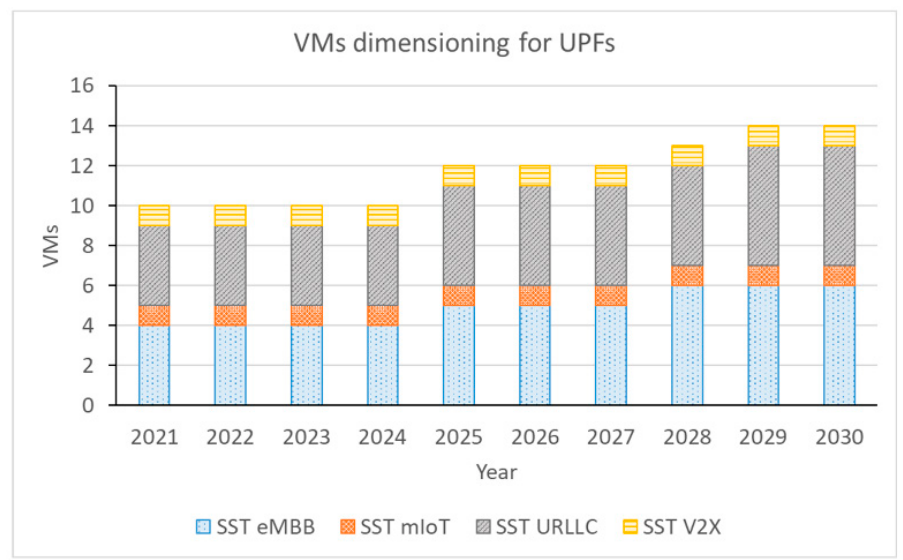
Figure 5. VMs dimensioning for UPFs.